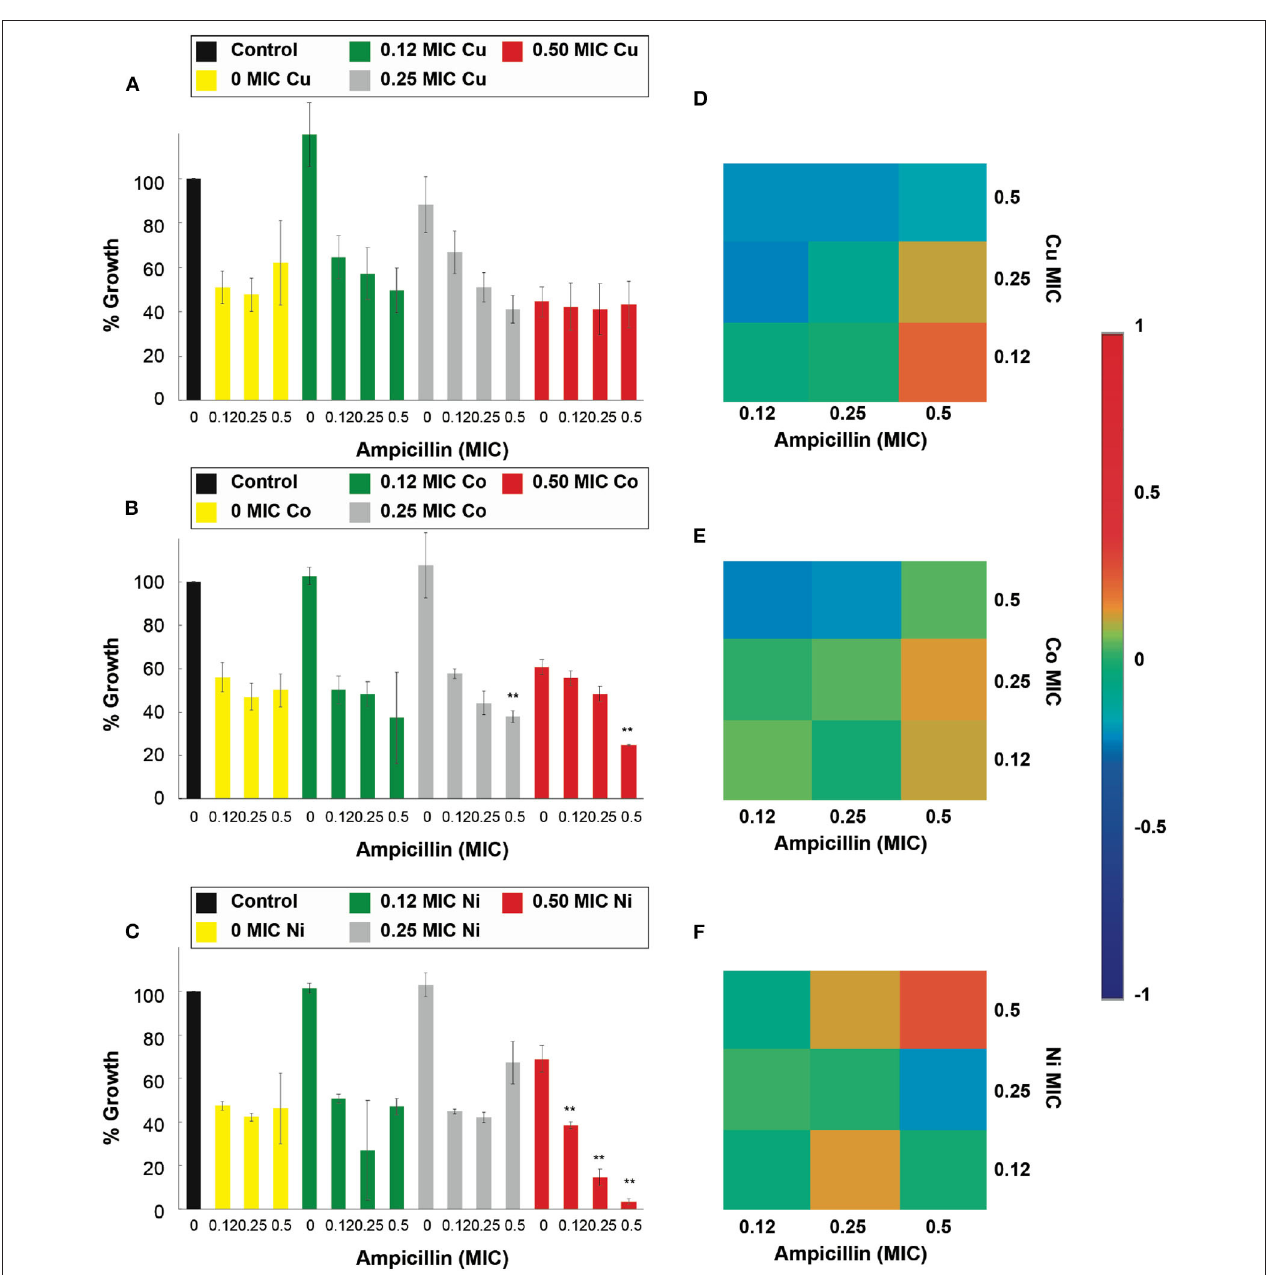
FIGURE 4 | Antimicrobial effect and interactions of ATMCs in S. aureus . Growth percentage by sub-inhibitory concentrations of metal ion-antibiotic combinations: (A) Cu 2 + -ampicillin, (B) Co 2 + -ampicillin, and (C) Ni 2 + -ampicillin against S. aureus ATCC 6538. Classification of the different interactions between metal ion-antibiotic combinations. The interactions of (D) Cu 2 + -ampicillin, (E) Co 2 + -ampicillin, and (F) Ni 2 + -ampicillin combinations are classified as synergistic, additive or antagonist, value > 0, = 0, and < 0, respectively. Each experiment was done in triplicates. **Corresponds to a significant difference ( p < 0.05) concerning the control and each of the individual treatments. Error bars correspond to the standard deviation from experiments performed in